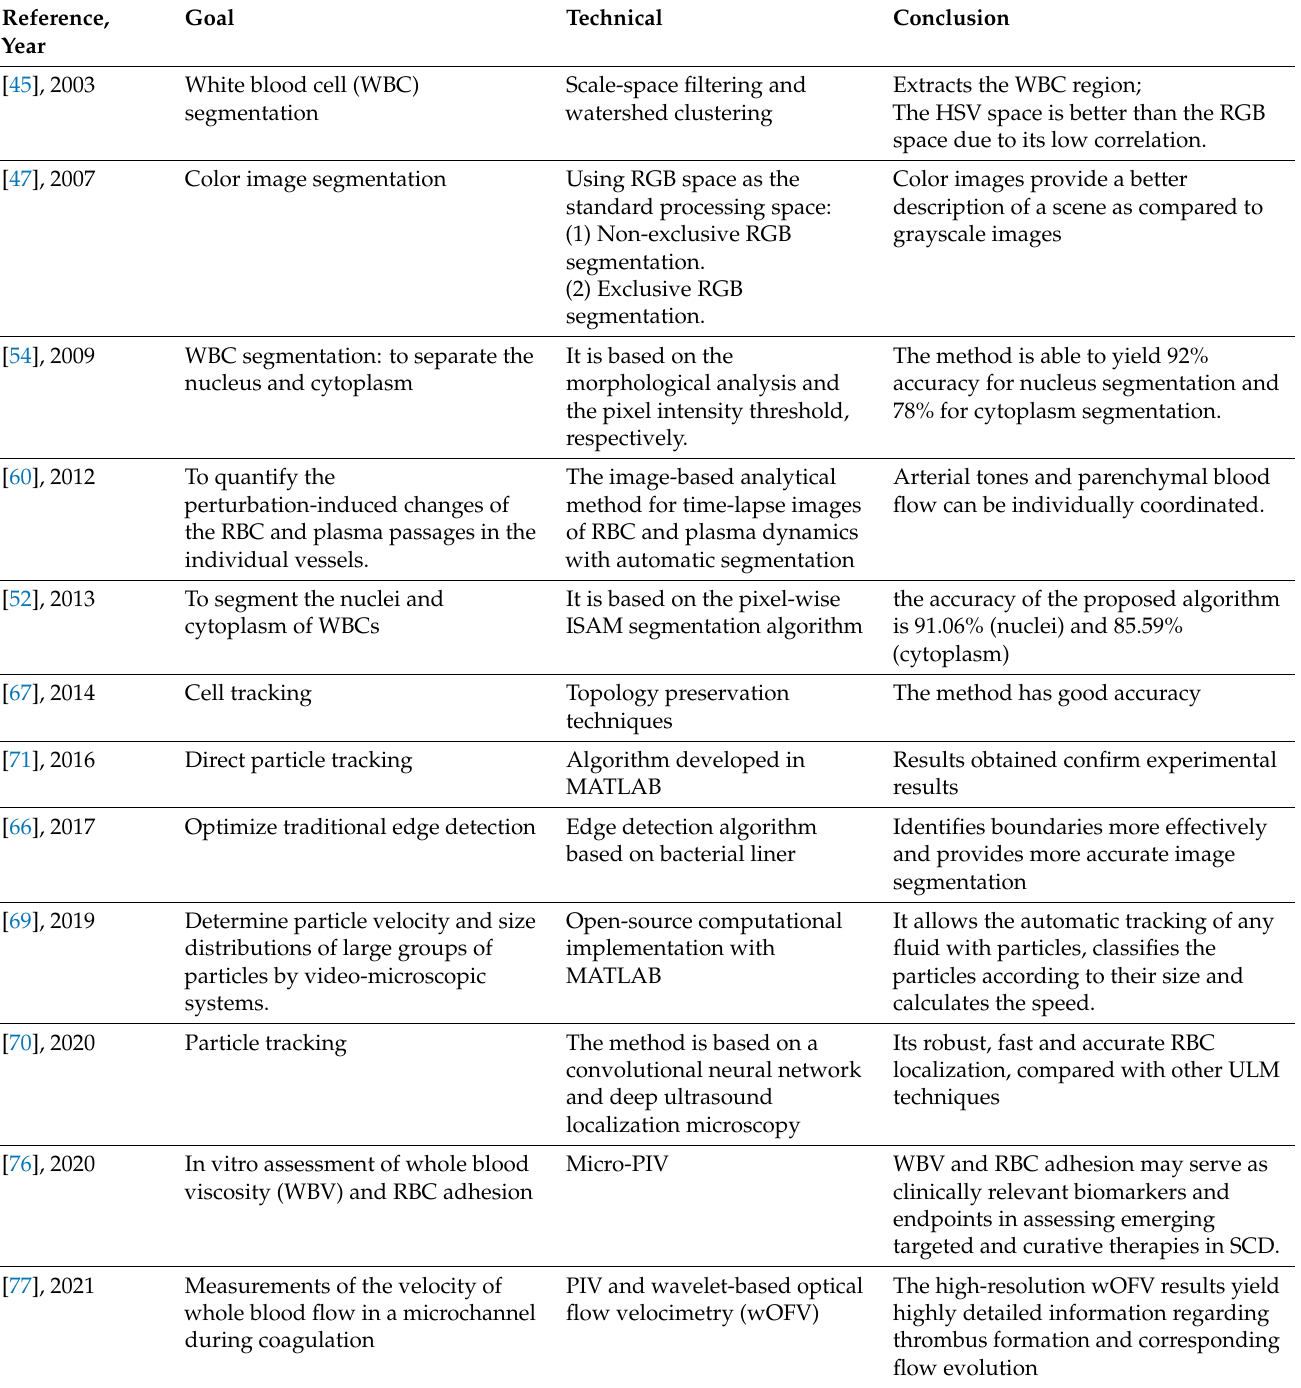
Table 1. Summary of image analysis methods used for cell tracking and